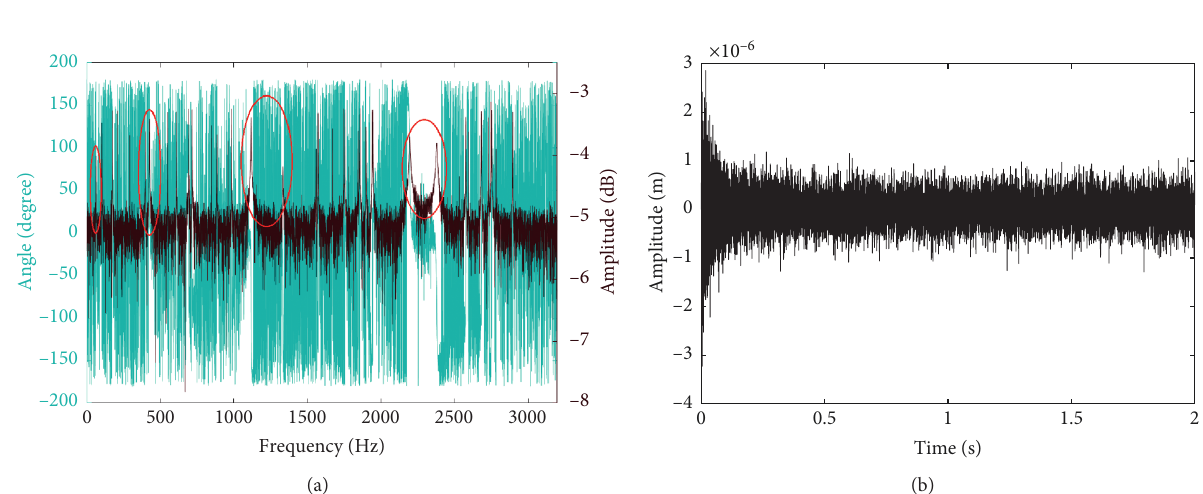
Figure 3: (a) FRF signal with the added noise. (b) IRF signal with the added